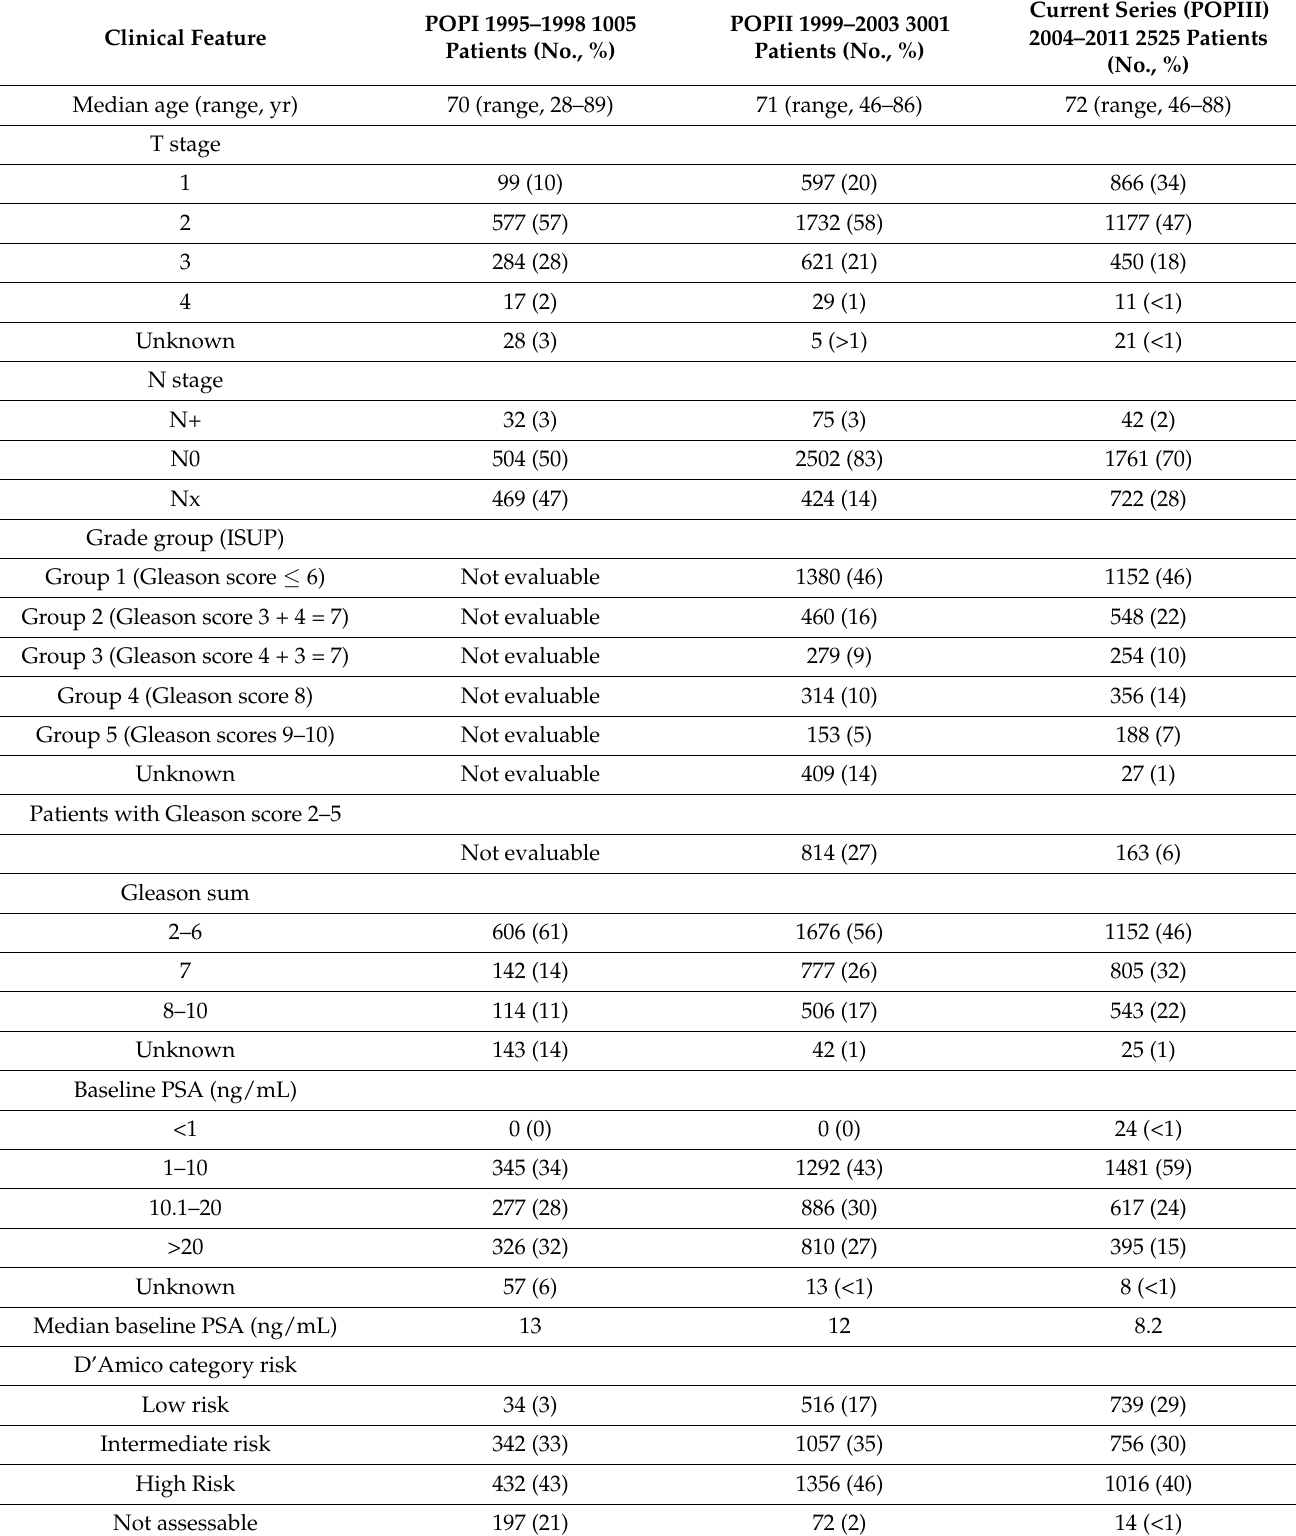
Table 1. Clinical features of the patients enrolled in the three subsequent